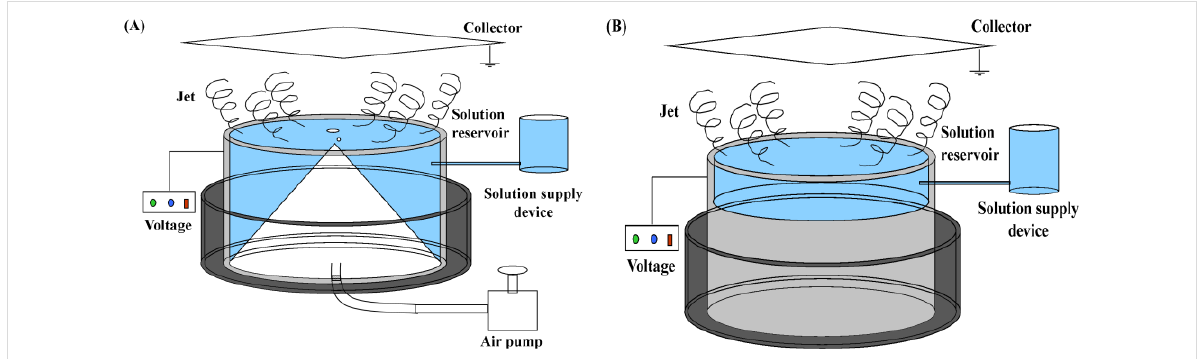
Figure 1: Schematic of (A) the modified bubble electrospinning (MBE) [21] and (B) the free surface electrospinning (FSE) (without air pump) devices.